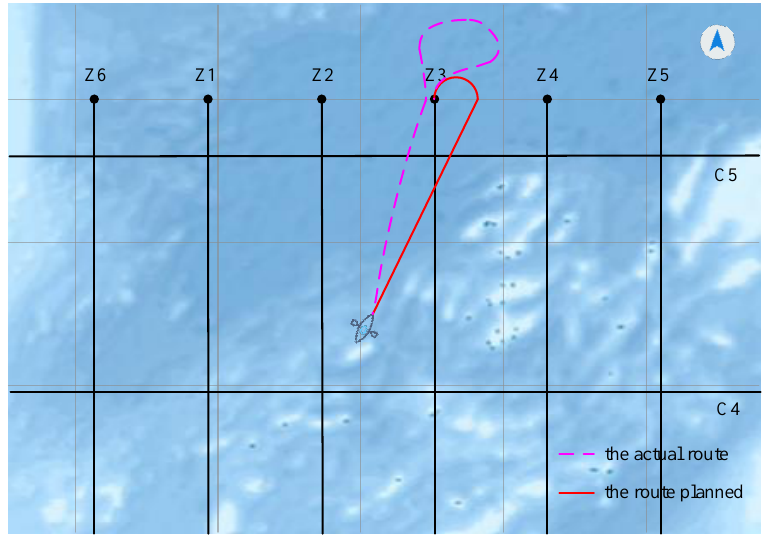
Figure 15. Comparison of the route planned by the proposed method and the actual situation.